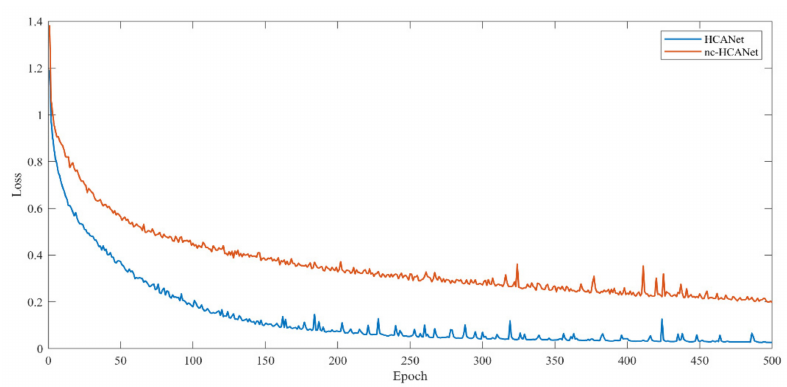
Figure 8. Training loss of Vaihingen dataset.